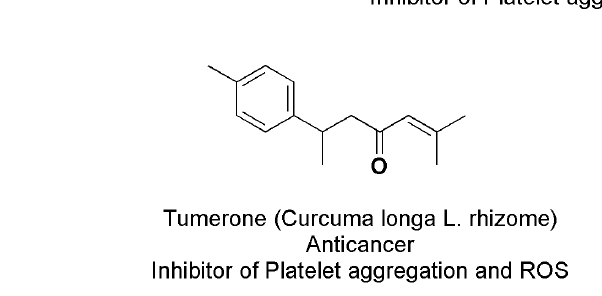
Figure 3. Structures of BACs mentioned in the main text.